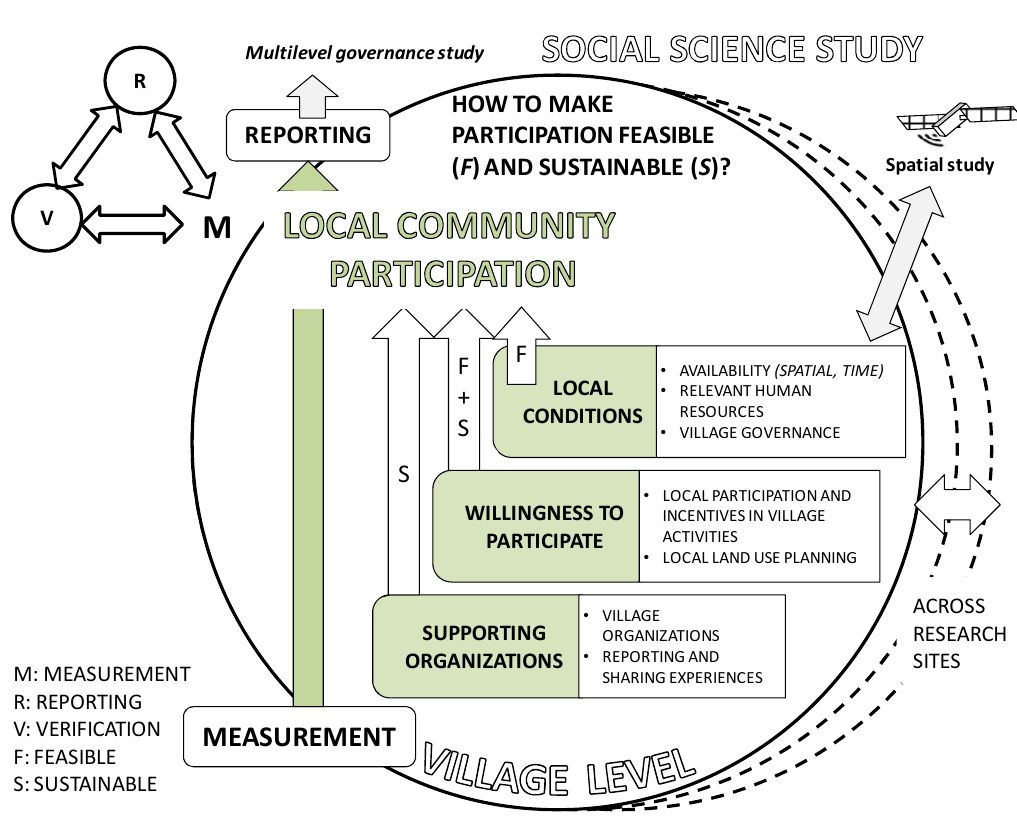
Figure 2. The social science research design.